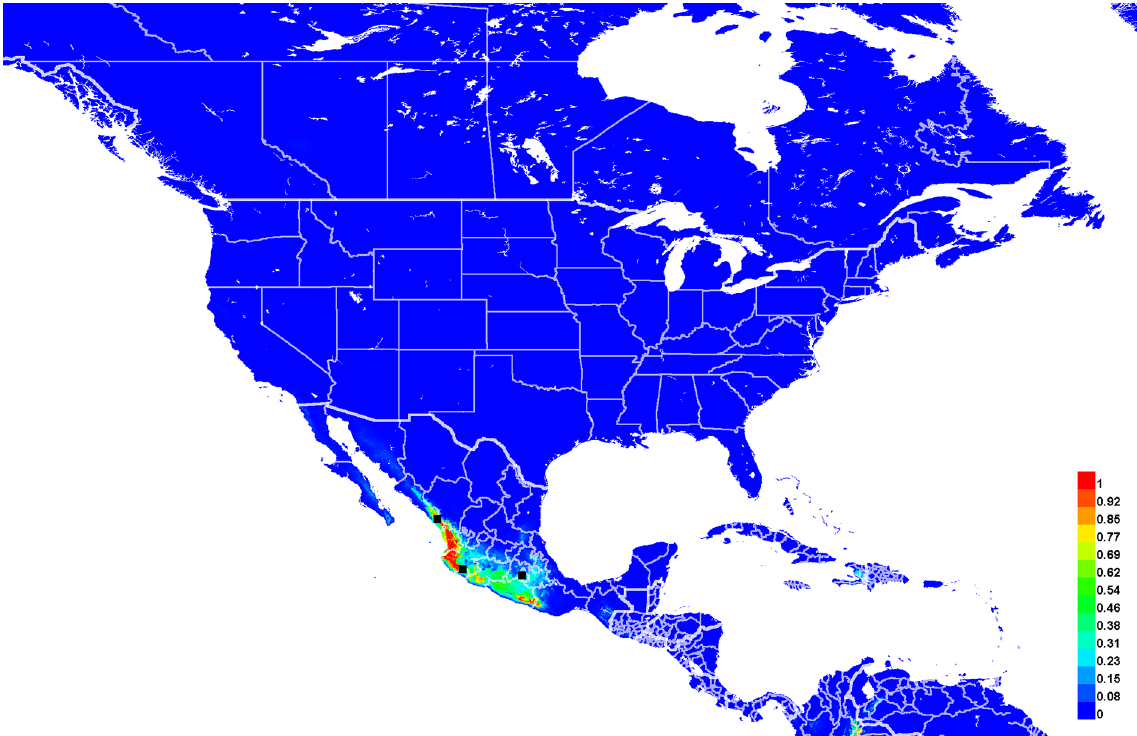
Fig. 86. Georeferenced collection records of Lasioglossum ( D. ) torrens sp. nov. (black squares) and predicted distribution by maximum entropy ecological niche modeling in Maxent (colour shading). Warmer colours indicate higher cloglog probability of occurrence. Due to the very small number of records, this distribution should be interpreted with